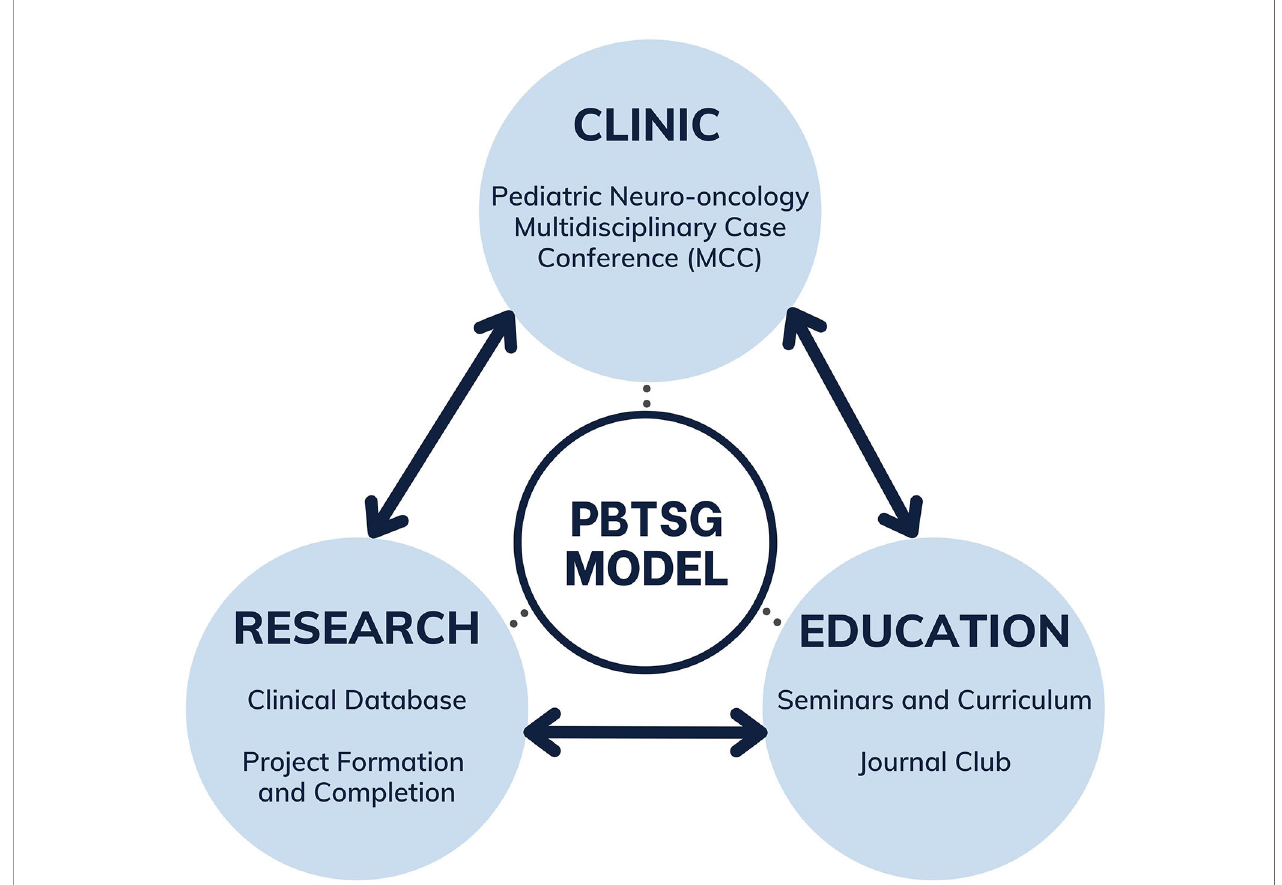
FIGURE 1 | Multifaceted model connecting clinical observations to educational initiatives and research endeavours of the